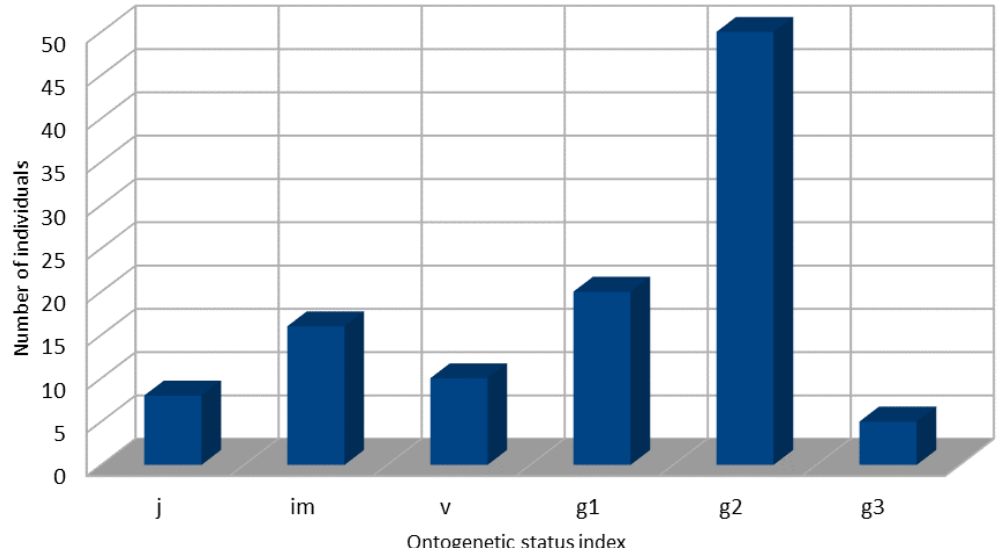
Fig. 2. Ontogenetic structure of the C. ucrainica population (between the villages of Bezkrovne, Svydnya and Krolevecz) Note: Reduction of ontogenetic status (index): j ‒ juvenile, IM ‒ immature, V ‒ virgin, g1 – young generative, g2 – mature generative, g3 ‒ old